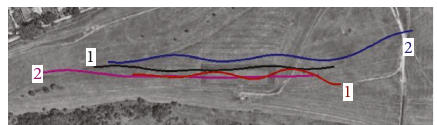
Figure 5: Three crossing possibilities of the own horizontal plane (red cross: intruder; blue circle: own A/C).